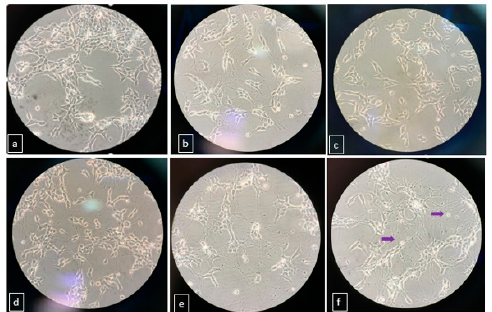
Figure 1. Morphology and network formation of differentiated and undifferentiated SH-SY5Y cells at different treatment periods. ( a ) undifferentiated ( b ) treated with RA for 5 days ( c ) treated with RA